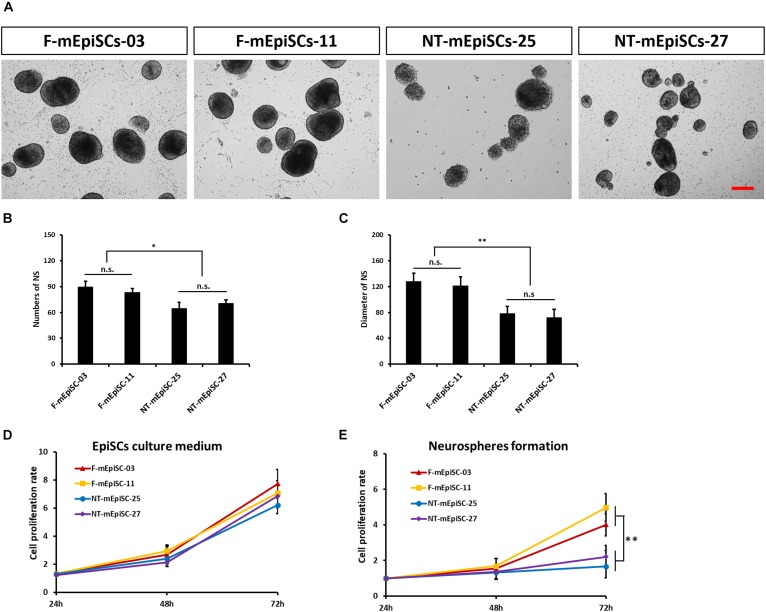
Quantification of neurosphere formation from F-mEpiSCs and NT-mEpiSCs. (A) Morphology of neurospheres formed from F-mEpiSCs and NT-mEpiSCs. (B,C) Numbers and average diameter of neurospheres derived from F-mEpiSCs and NT-mEpiSCs. (D) Cell proliferation rate of F-mEpiSCs and NT-mEpiSCs cultured in EpiSC culture medium. (E) Cell proliferation rate of F-mEpiSCs and NT-mEpiSCs during neurosphere formation. Scale bar: 100 μm; n.s., P > 0.05; ∗P < 0.05; ∗∗P < 0.01.